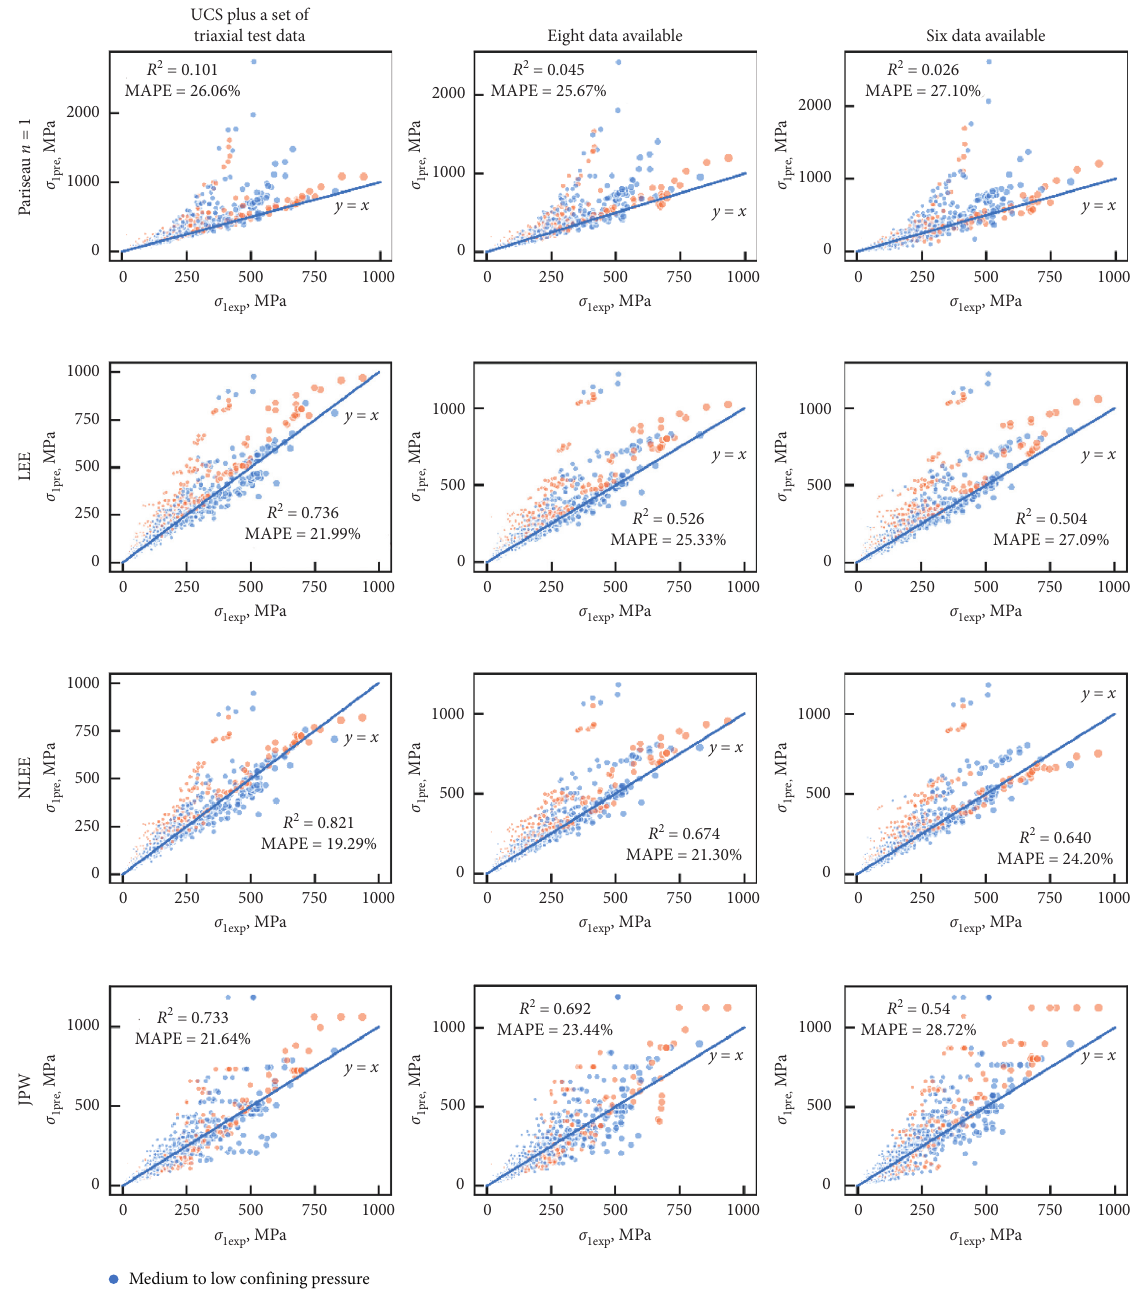
Figure 8: Predicted vs. experimental σ